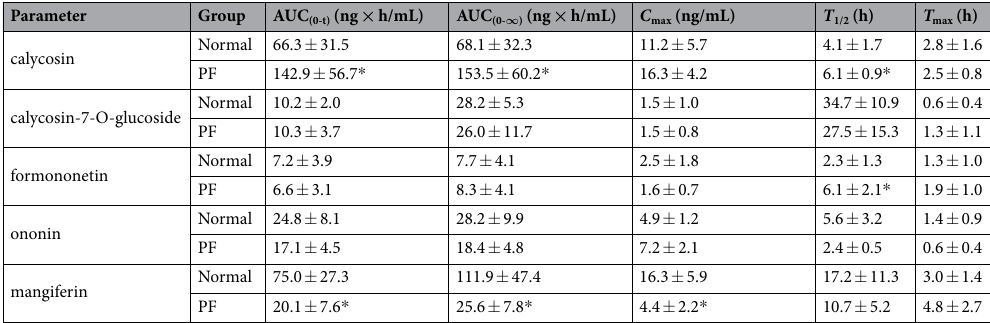
Table 3. The main pharmacokinetic parameters of calycosin, calycosin-7-O-glucoside, formononetin, ononin and mangiferin after the oral administration of PRM (mean ± SD; n = 6). * P < 0.05 compared with the normal